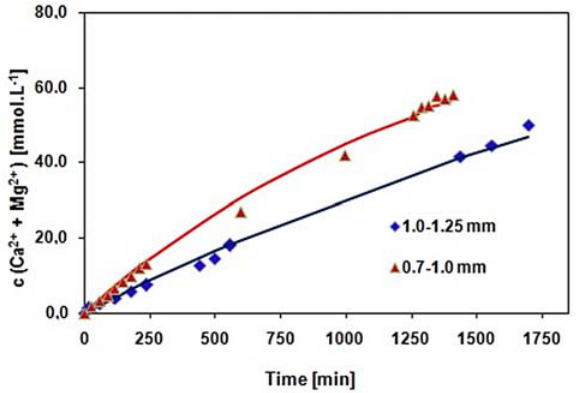
Figure 6. Time dependencies of (Ca 2+ + Mg 2+ ) content during re- carbonization experiments in FBRR (Q rimental values (points) and calculated values